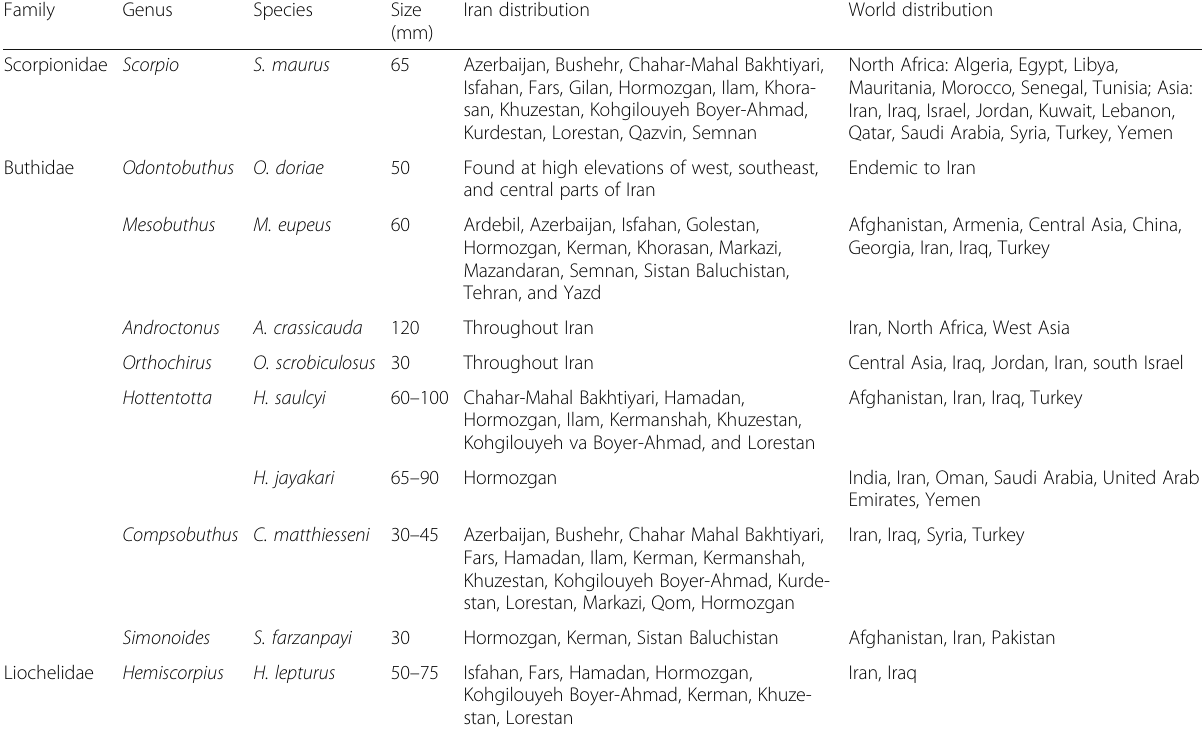
World distribution